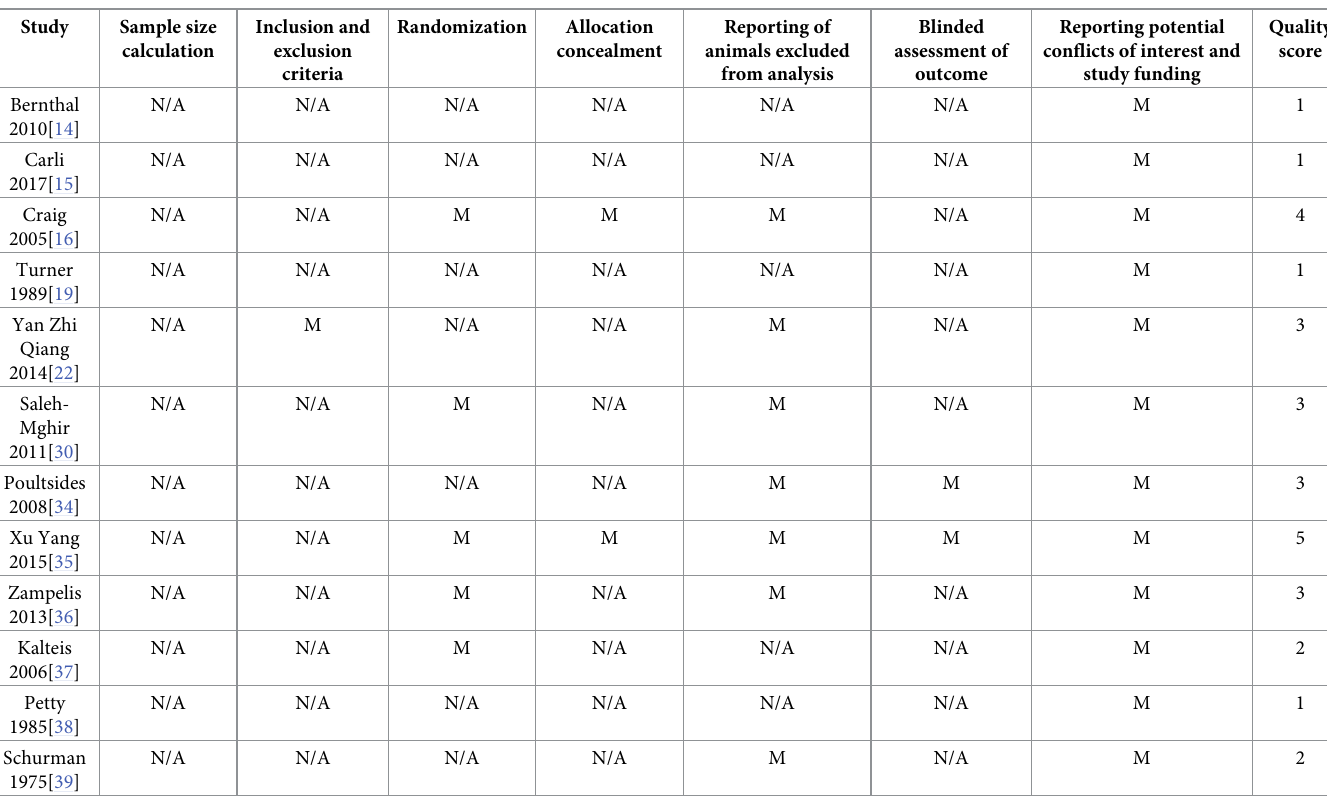
Table 3. Risk of